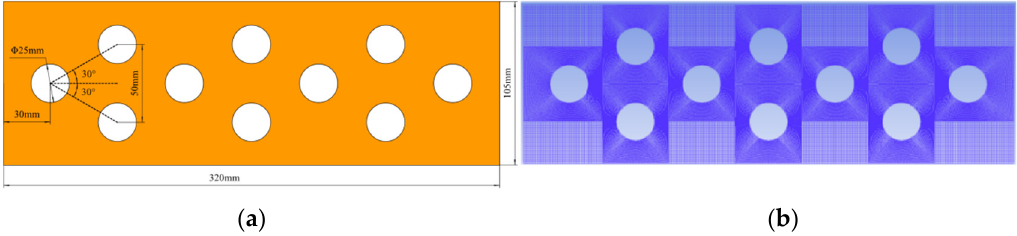
Figure 6. Two-dimensional calculation model of PCM upper surface. ( a ) Geometric parameters of the model. ( b ) Meshing of the model.